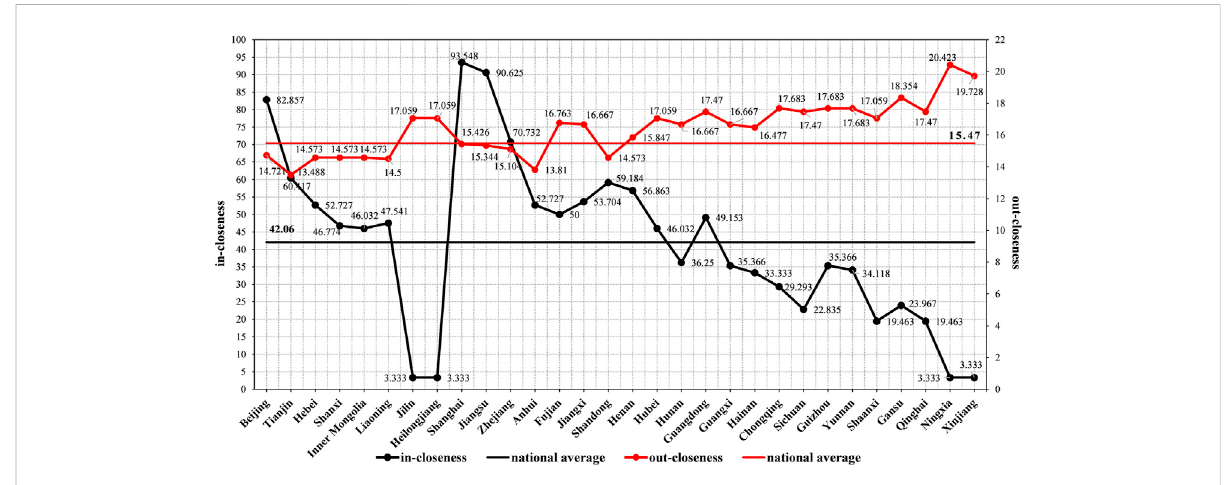
FIGURE 6 The in-closeness and out-closeness centrality of the transportation GTFP